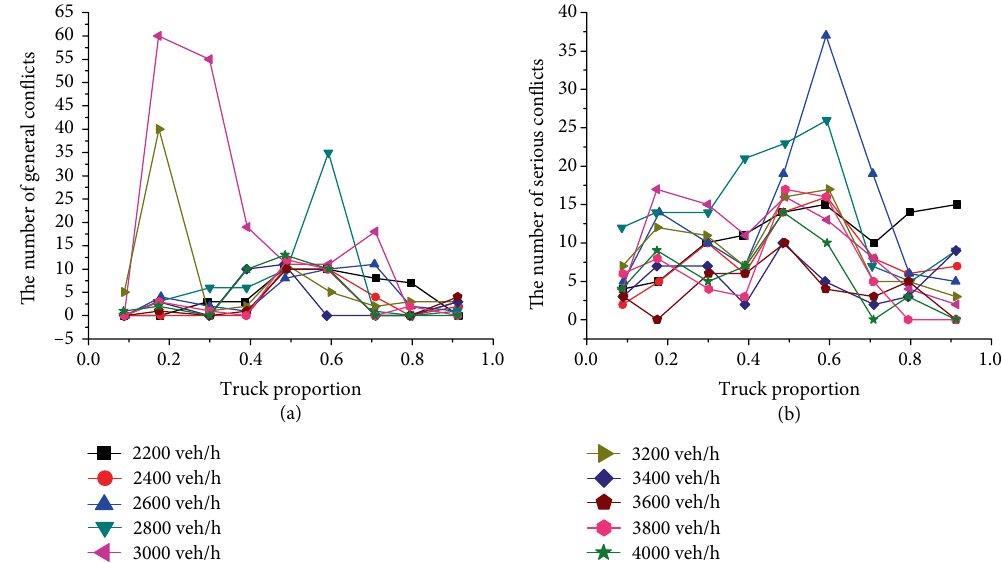
Figure 3: The relationship between truck proportion and TTC.